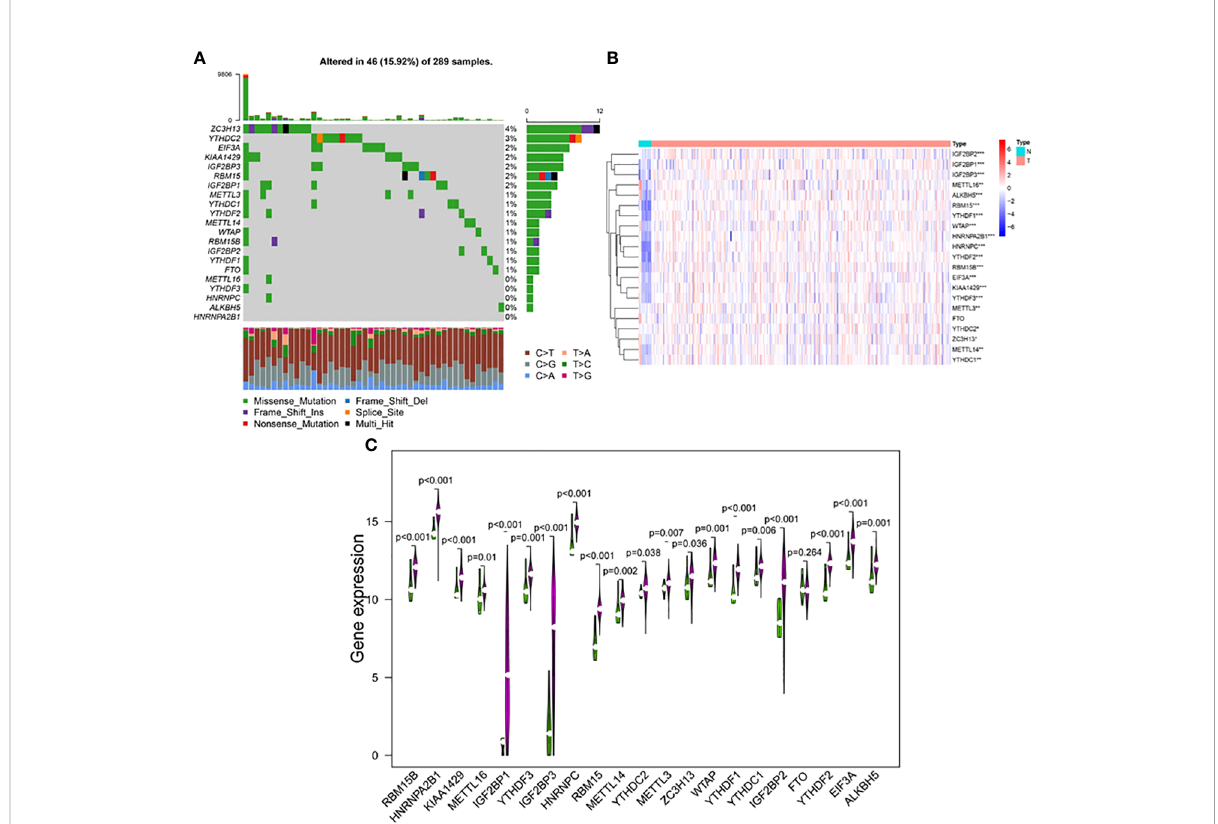
FIGURE 2 (A) The mutation frequency of 21 m6A regulators in 289 patients with cervical cancer from the TCGA-CESC cohort. Each column represented individual patients. The upper bar plot showed TMB, and the number on the right indicated the mutation frequency in each regulator. The right bar plot showed the proportion of each variant type. The stacked bar plot below showed fraction of conversions in each sample. The expression levels of m6A RNA methylation regulators between tumor and normal samples in TCGA CESC and GTEx cohorts. (B) Heatmap of m6A RNA methylation regulator expression level in each sample. (C) The expression difference of m6A RNA methylation regulator between tumor and normal samples. * p < 0.05; ** p < 0.01; *** p <